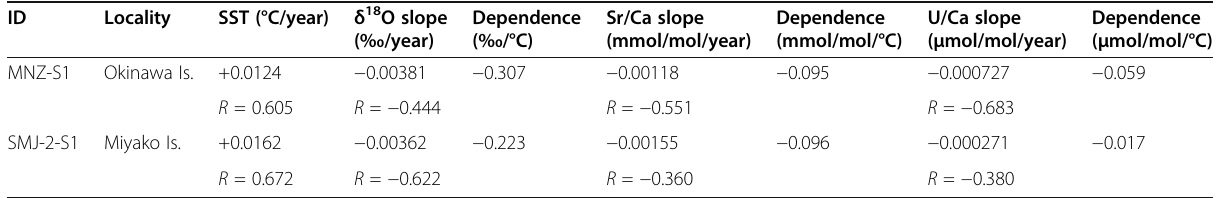
Table 2 Post-1960 trends estimated from SST and sclerosponge δ 18 O, Sr/Ca, U/Ca records